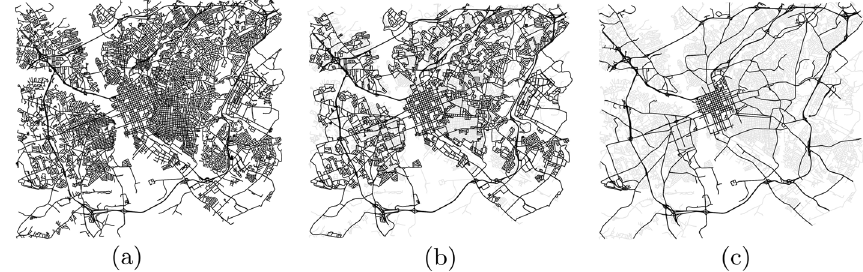
Fig. 6 Visualization of the road network in the city of Columbia: a input network, b simplified by the proposed method, and c simplified by omitting all residential